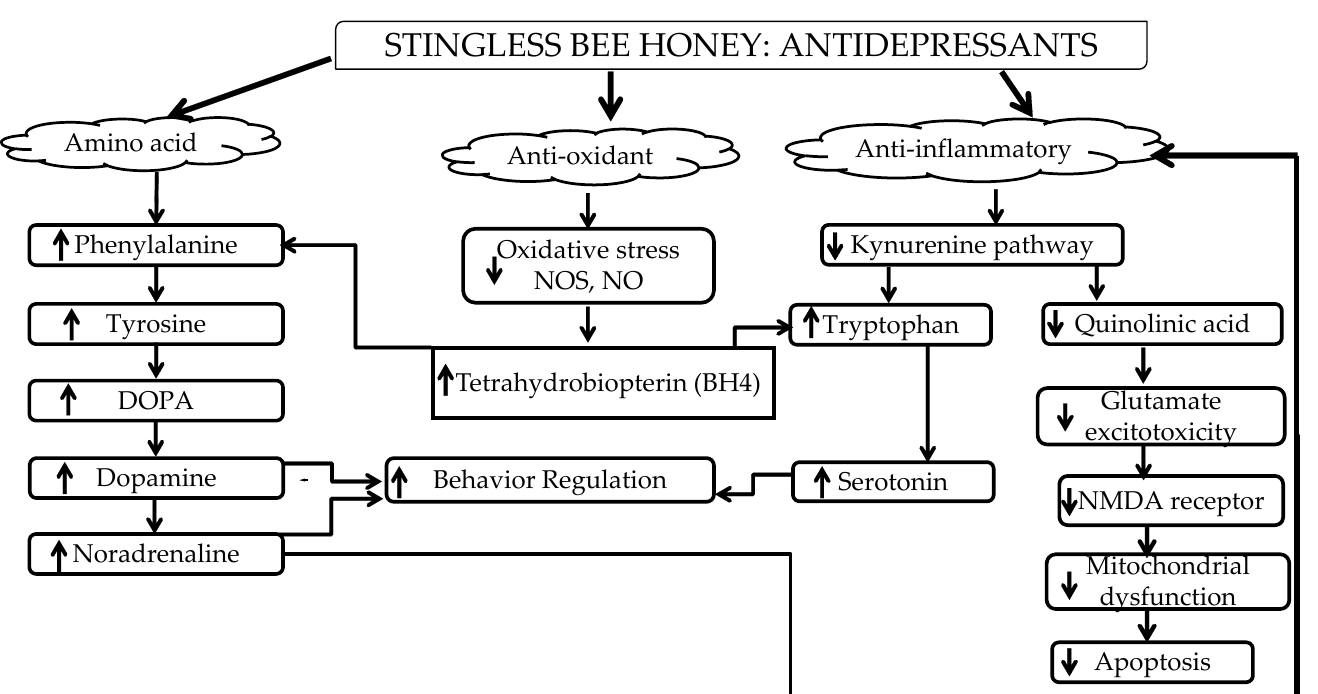
Figure 2. Summary of the anti-depressive effects of SBH.